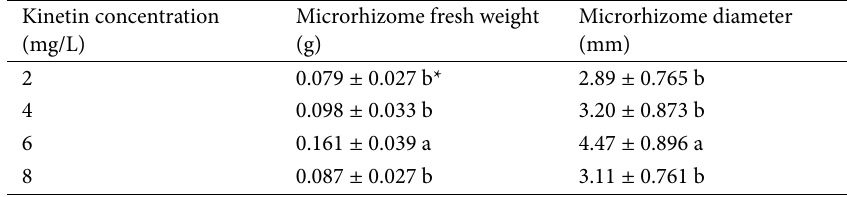
Table 4 Effect of kinetin concentrations on microrhizome growth.